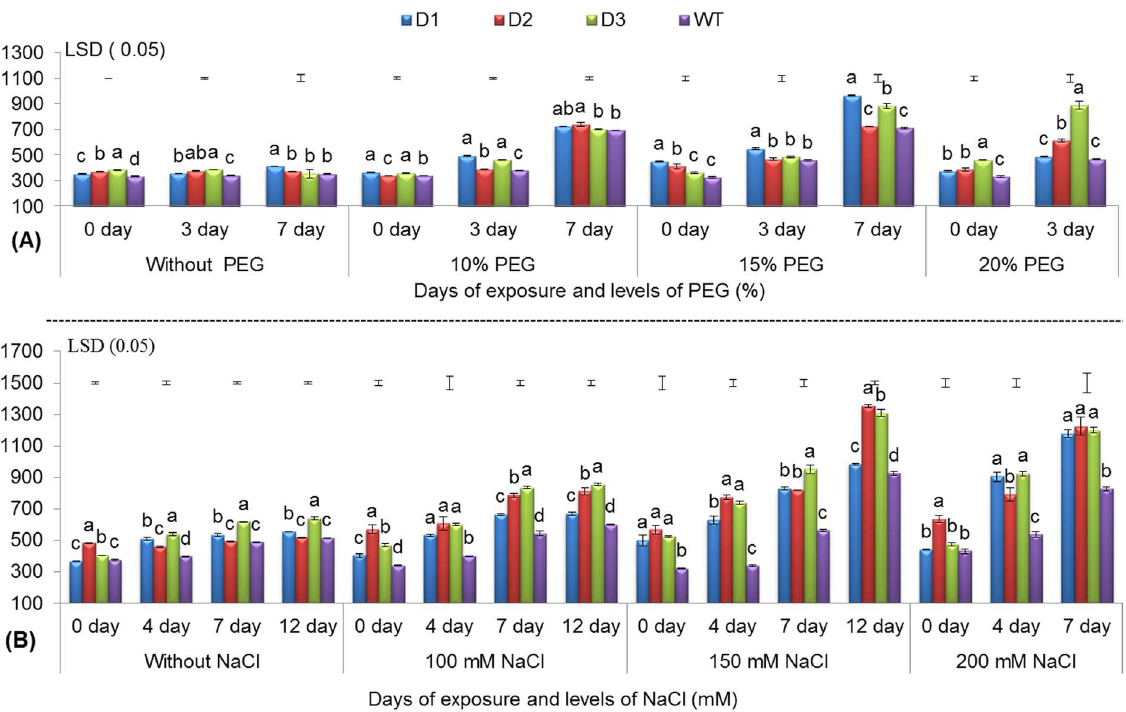
Fig. 2. Osmotic potential of three transgenic lines and WT. Under various levels of PEG (A) and NaCl (B) with increasing days of stress exposure (refer to Fig.